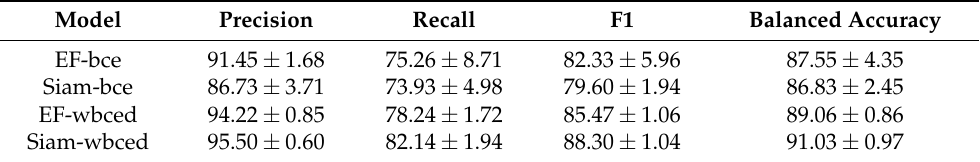
Figure 5. Confusion matrices obtained with the segmentation approach. The best results achieved with the k-fold cross validation technique are shown for (from left to right) EF-bce, Siam-bce, EF- wbced, and Siam-wbced methods. Rows are true unchanged (TU) and true changed (TC) classes (ground truths), whereas on columns are predicted unchanged (PU) and predicted changed (PC) classes (inference results). Table 3. Average percentage values of the considered metrics for the segmentation task. The uncertainties are estimated as the standard deviations over the five models trained with the k-fold cross